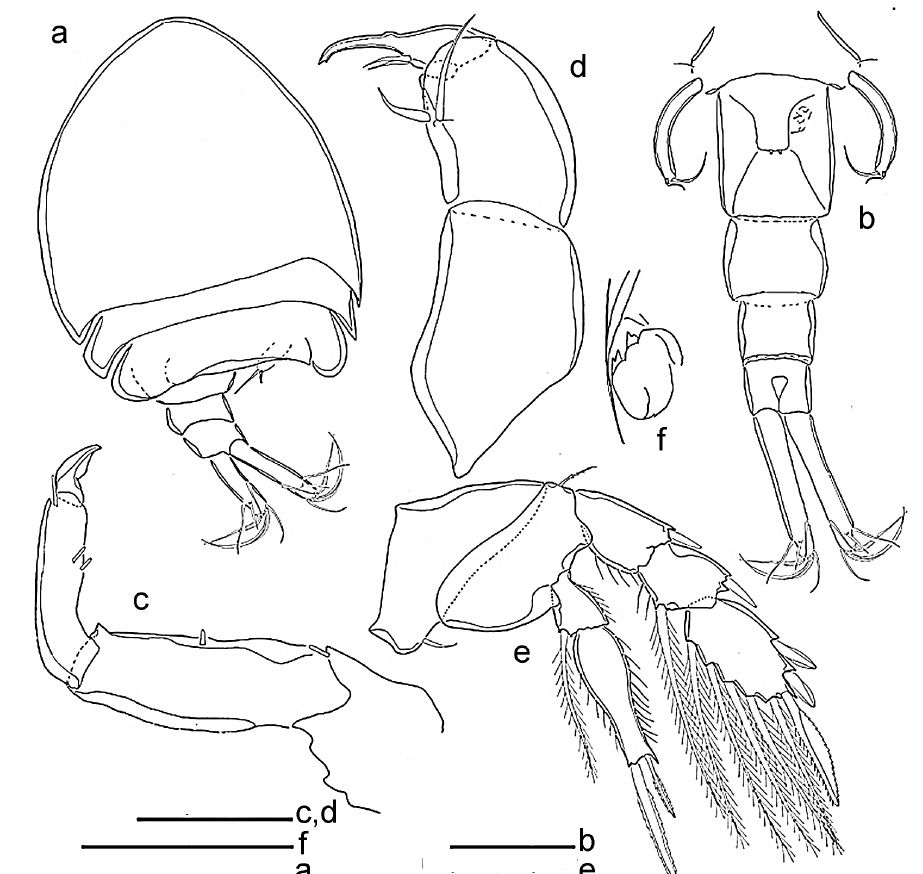
Figure 6. Spaniomolgus maculatus sp. n., female. a Habitus dorsal b Urosome dorsal c Antenna d Maxil- liped e Leg 4 f Genital area. Scale bars: 300 μm ( a ); 100 μm ( b ); 50 μm ( c–f ).